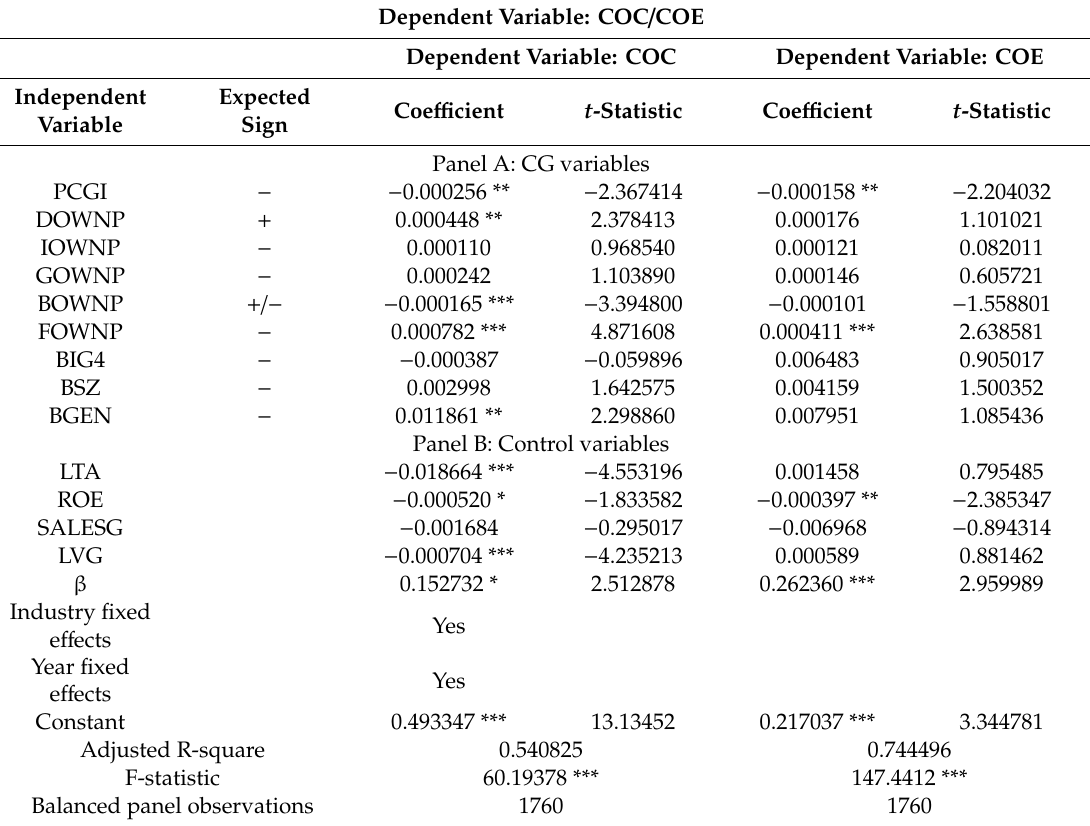
Table 4. Results based on cost of equity.